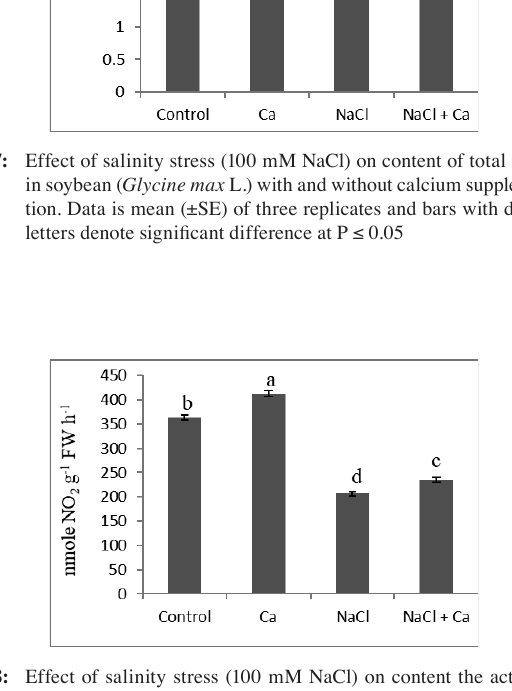
Fig. 8: Effect of salinity stress (100 mM NaCl) on content the activity of nitrate reductase in soybean ( Glycine max L.) with and without cal‑ cium supplementation. Data is mean (±SE) of three replicates and bars with different letters denote significant difference at P ≤ 0.05